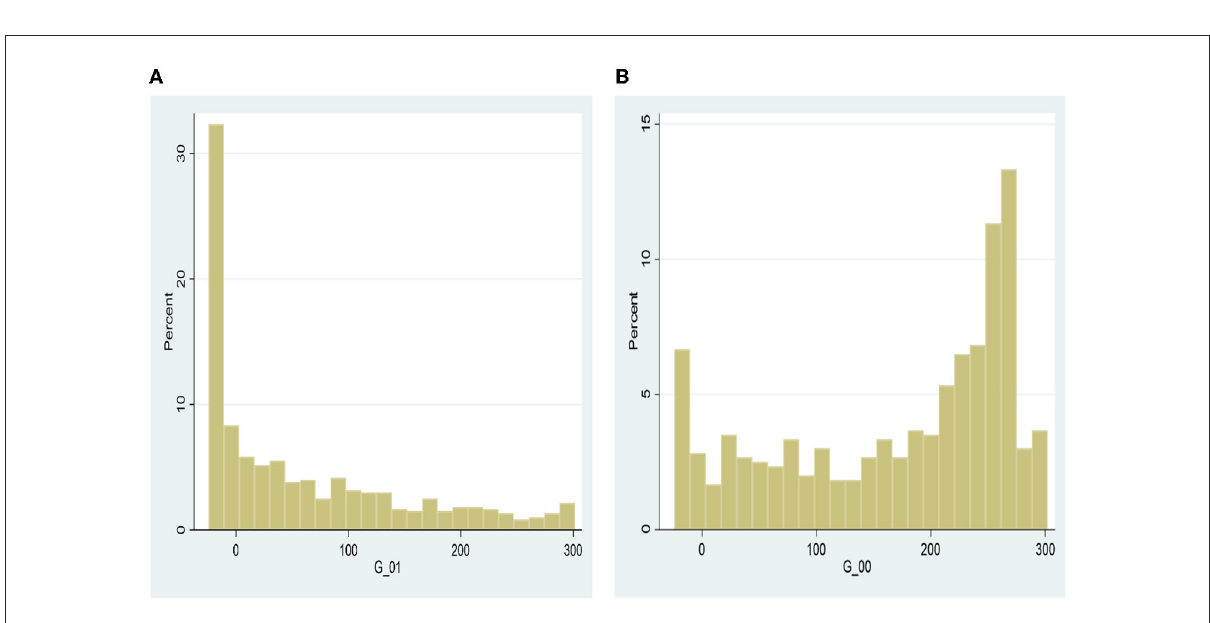
FIGURE7 Comparison of yield (Kg/Ha) distributions at the inefficiency frontier—indirect effect. (A) mediated-non-adopters, (B)